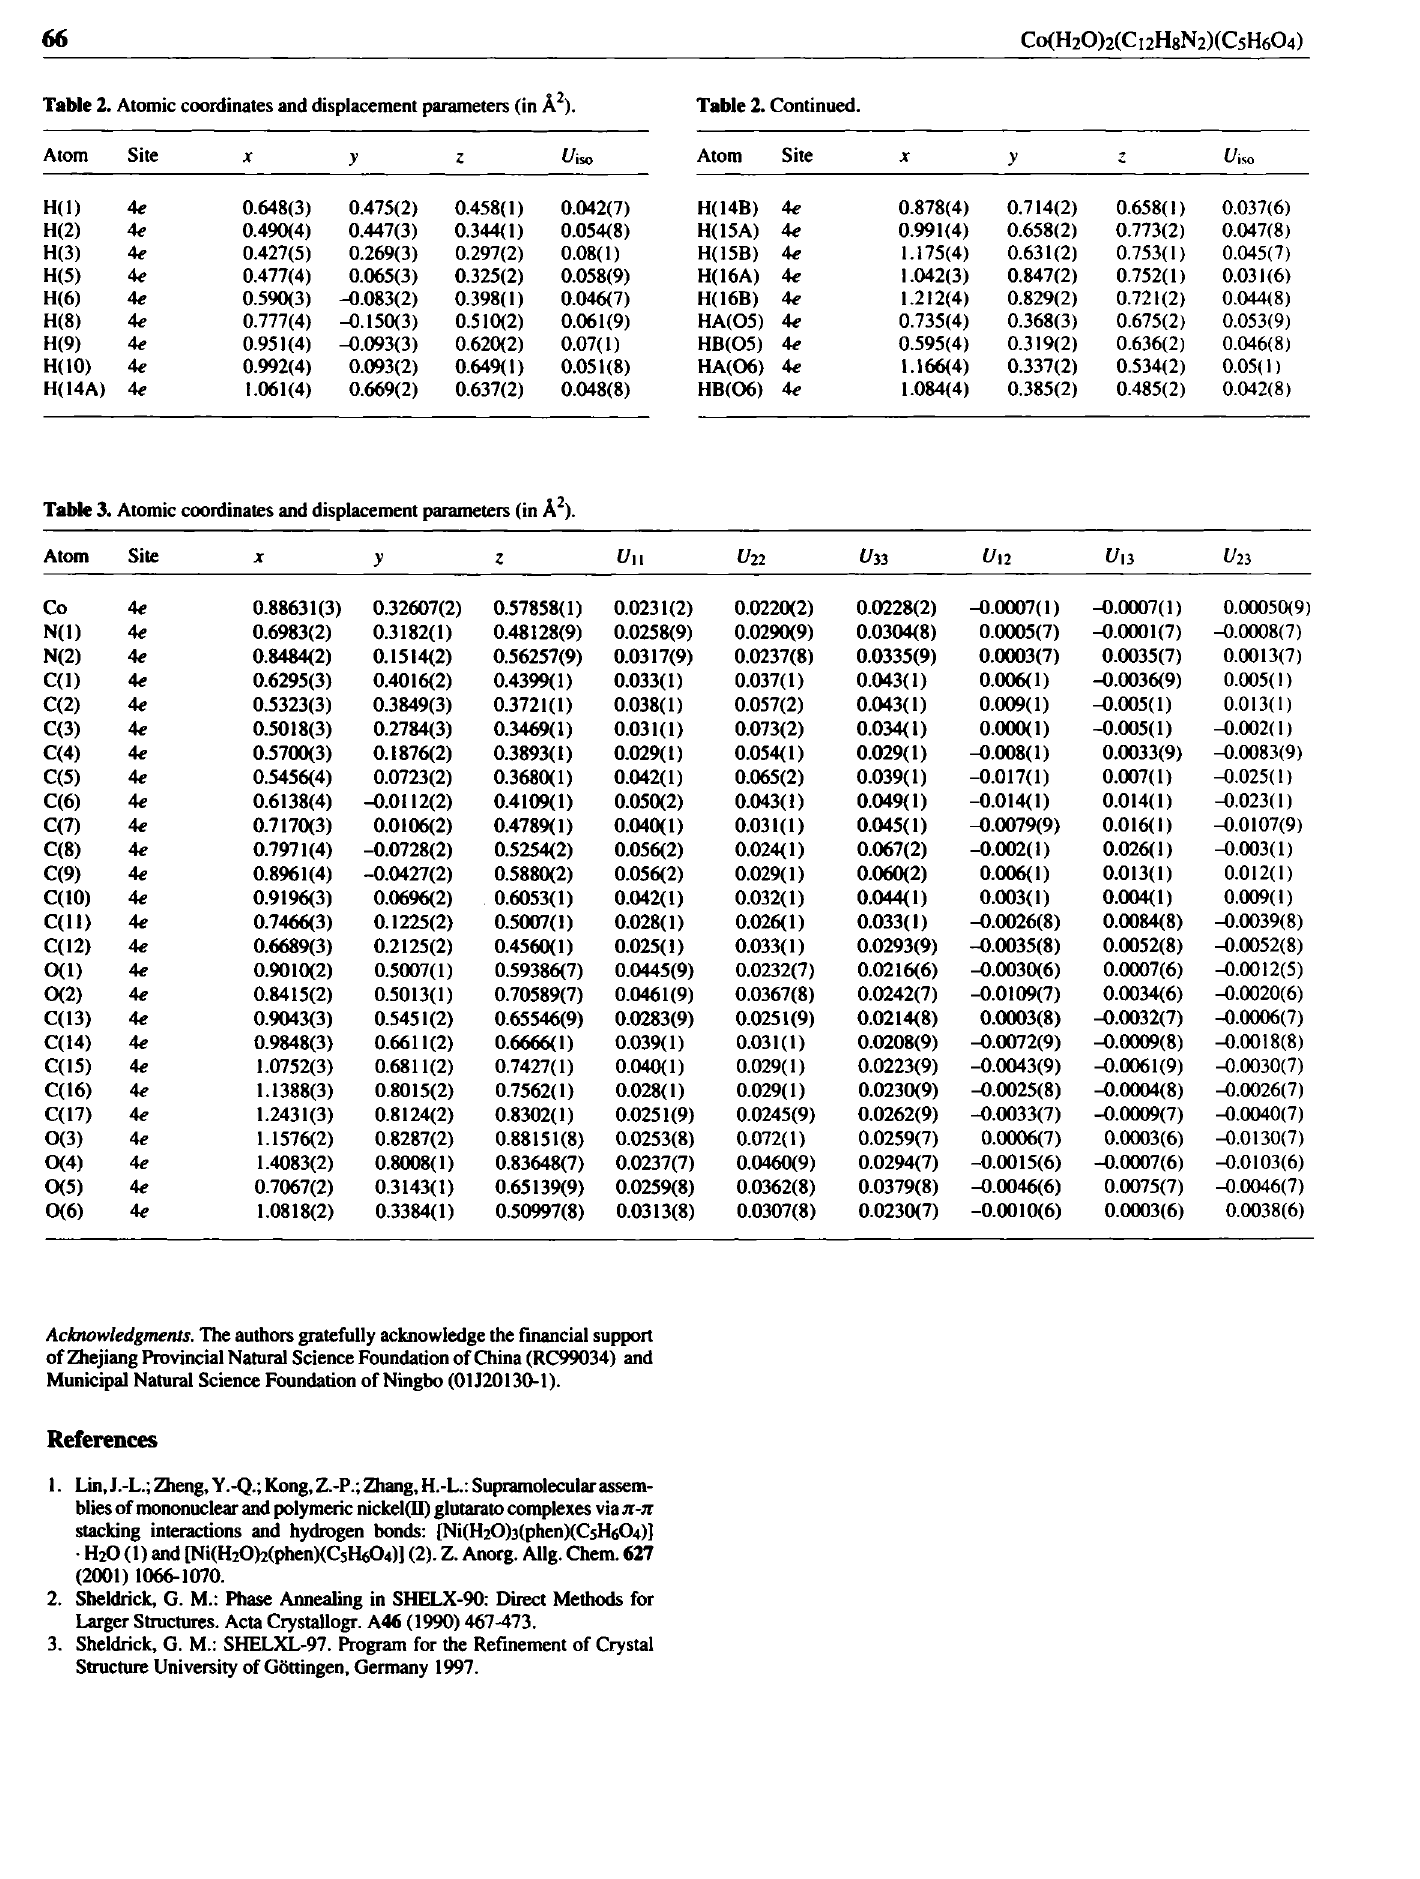
Table 2. Atomic coordinates and displacement parameters (in Â 2 ). Table 2. Continued.